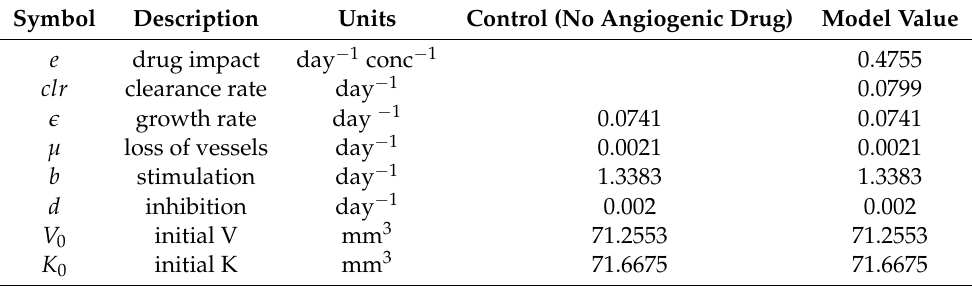
Table 1. Estimated tumor growth parameters [14].